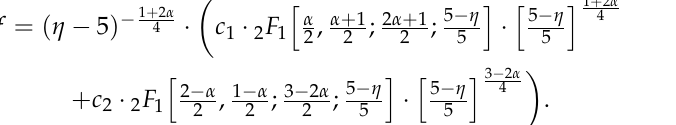
= c = c = 1 and d = − 1; 2 3 1